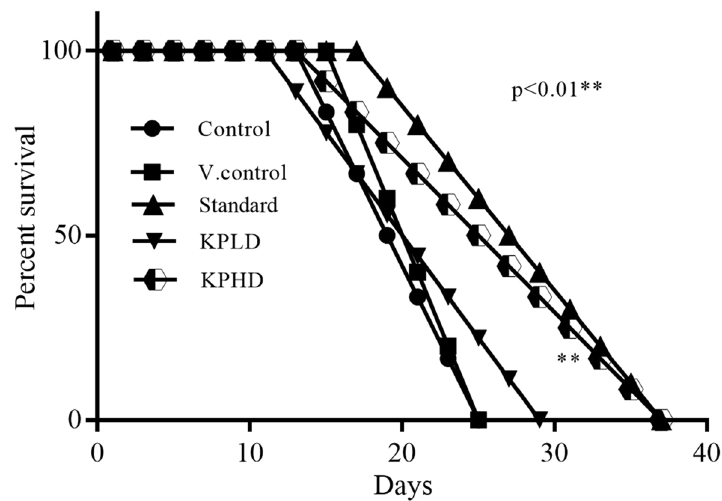
Fig. 6 Effect of K. pinnatum extract on the survival of ascites bearing animals. Results are presented as mean curve was used to analyse the statistical comparison followed by Mantel-Cox test. * P < 0.05, ** P < 0.01, *** P < 0.001, statistically significant as compared to the control